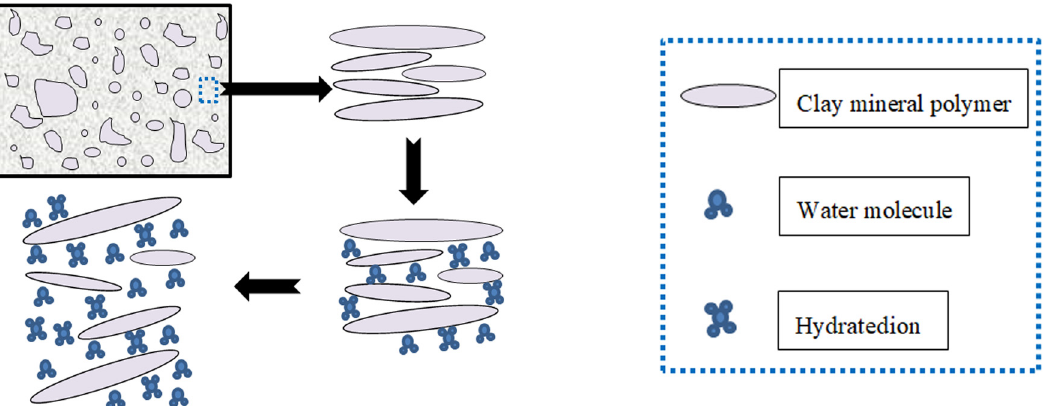
Figure 7: Diagram of expansion process of clay mineral polymer.